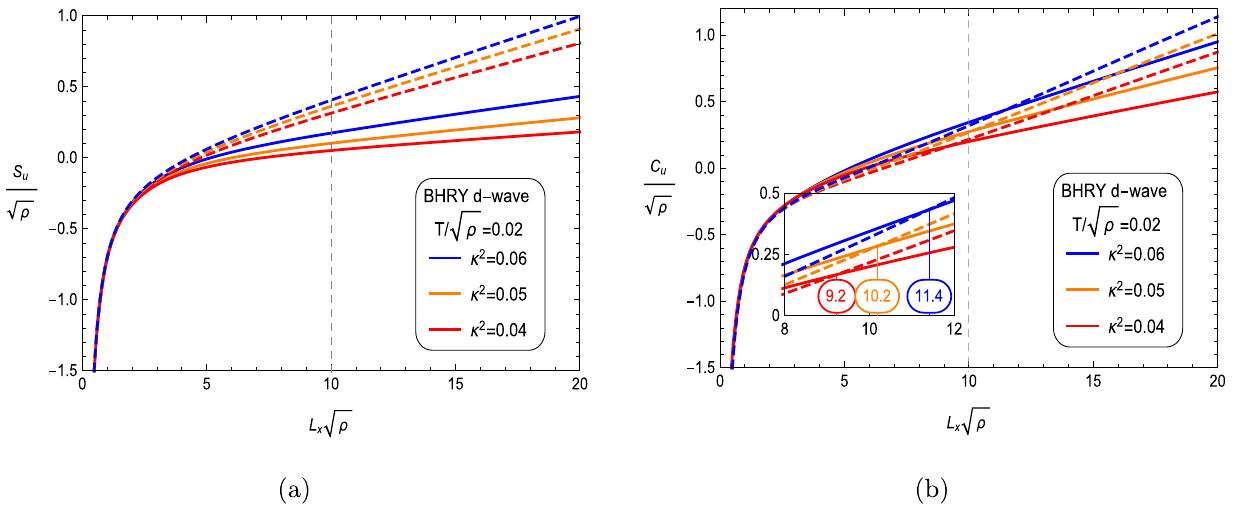
√ ρ for the BHRY d-wave superconductor with a fixed temperature T :